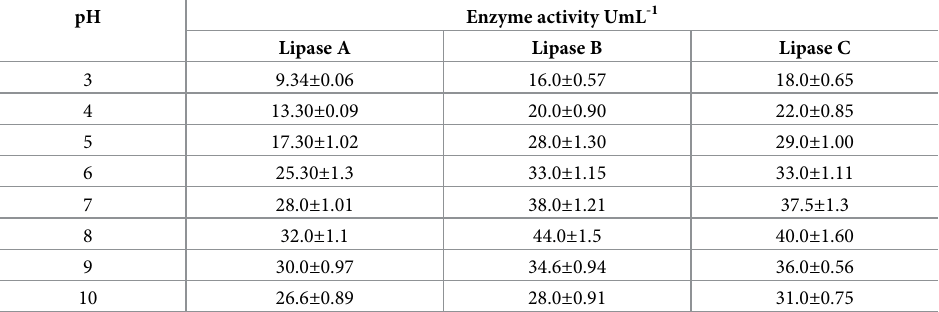
Table 2. Effect of pH on lipase production from B . cereus NC7401 cultured using starch (Lipase A), maltose (Lipase B), and tryptone (Lipase